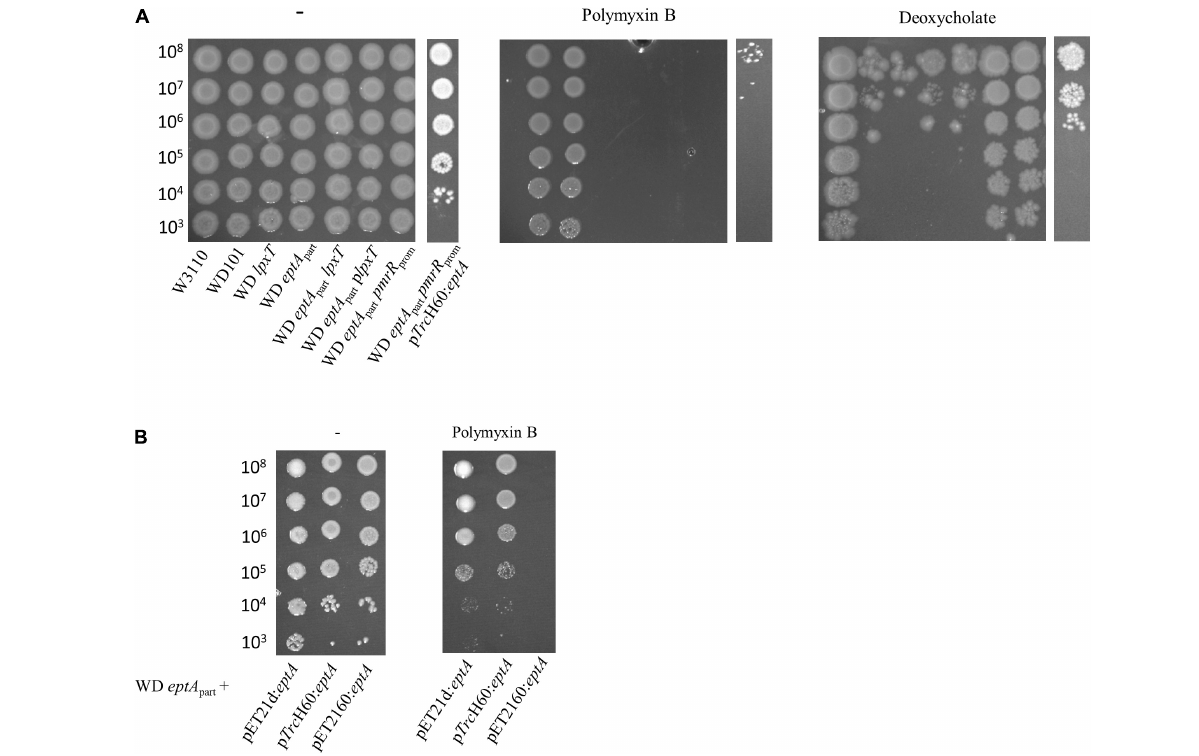
FIGURE 10 | Phenotypic analysis of WD eptA part strain and its derivatives. (A) WD eptA part strain and its derivatives were grown overnight in 2YT medium and 5- µ l spots of serial dilutions were deposited onto 2YT plates containing or not polymyxin B (2.5 µ g/ml) and deoxycholate (2.5 mg/ml). (B) Functional complementation assays with plasmids carrying eptA gene under the control of its own promoter (pET21d: eptA ), a trc promoter (p Trc H60: eptA ) or a T7 promoter (pET2160: eptA ). Cells were grown overnight in 2YT medium and 5- µ l spots of serial dilutions were deposited onto 2YT plates containing or not polymyxin B (2.5 µ g/ml). The data are representative of at least three independent